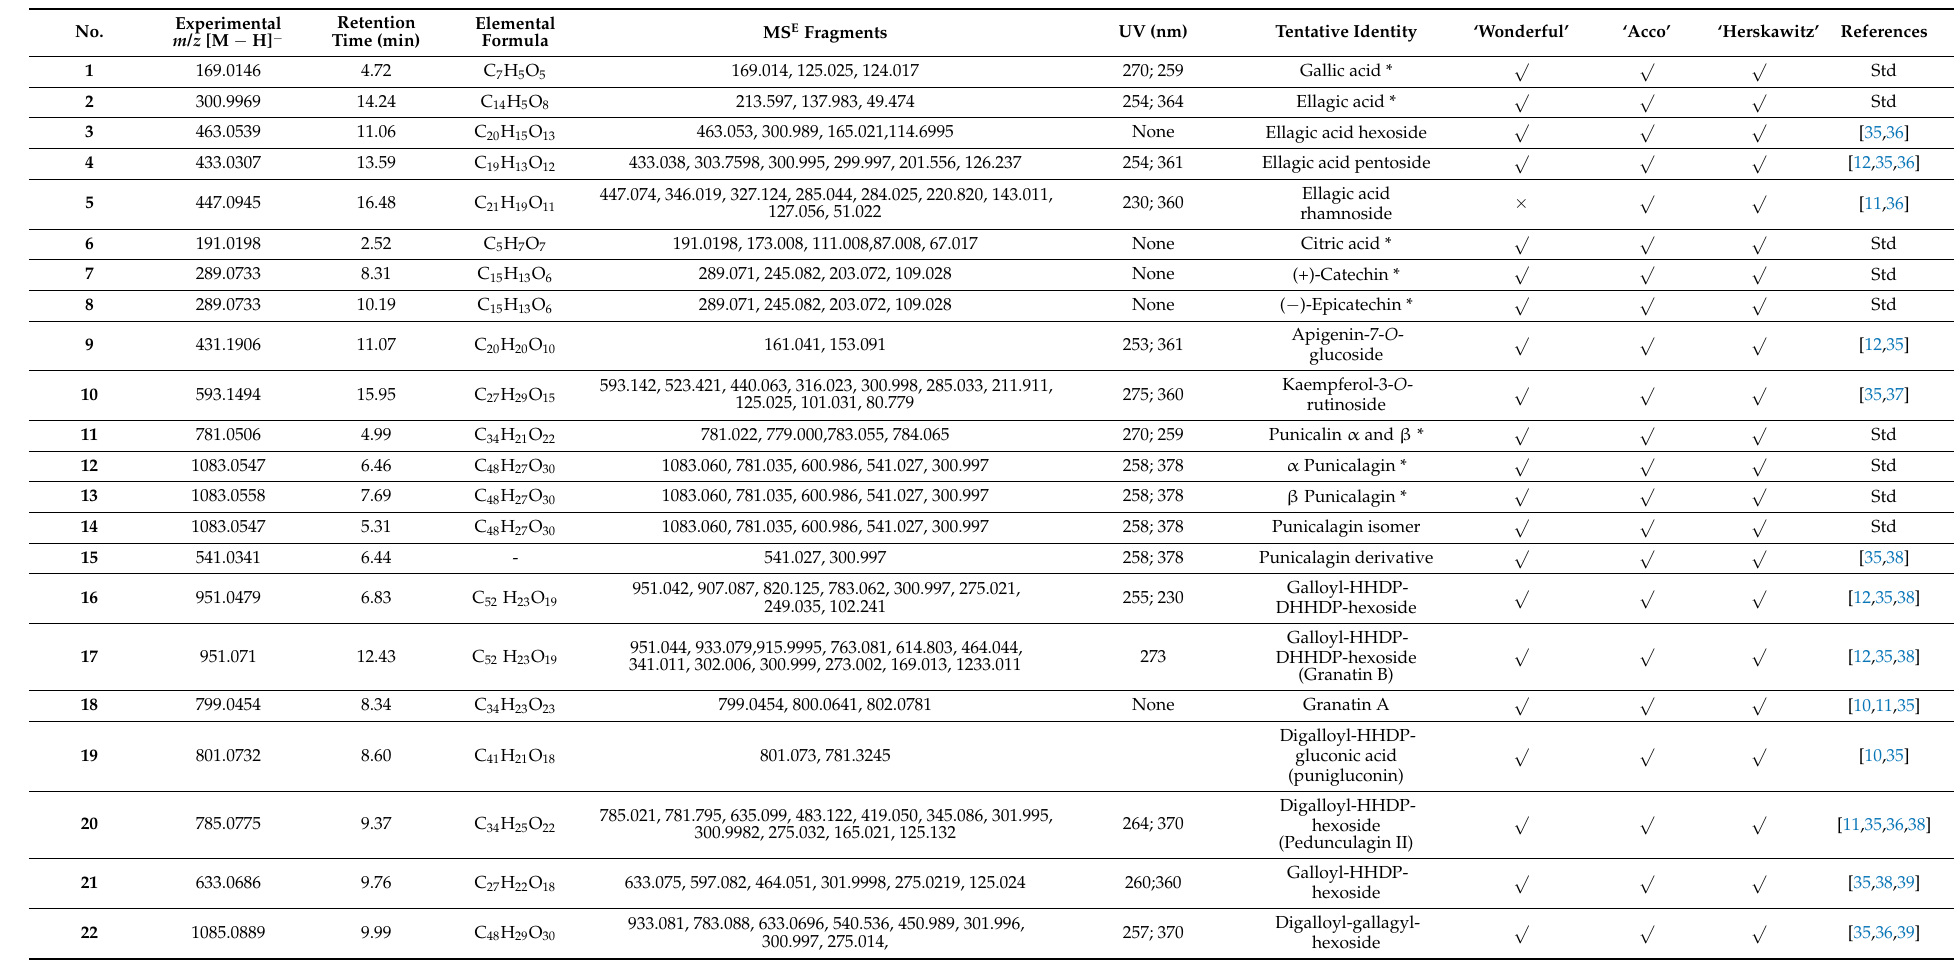
Table 3. List of compounds tentatively identified in P. granatum L. (‘Wonderful, ‘Acco’, and ‘Herskawitz’) peel extracts showing retention times, detected [M − H] − ion, elemental composition, MS E fragments, and UV